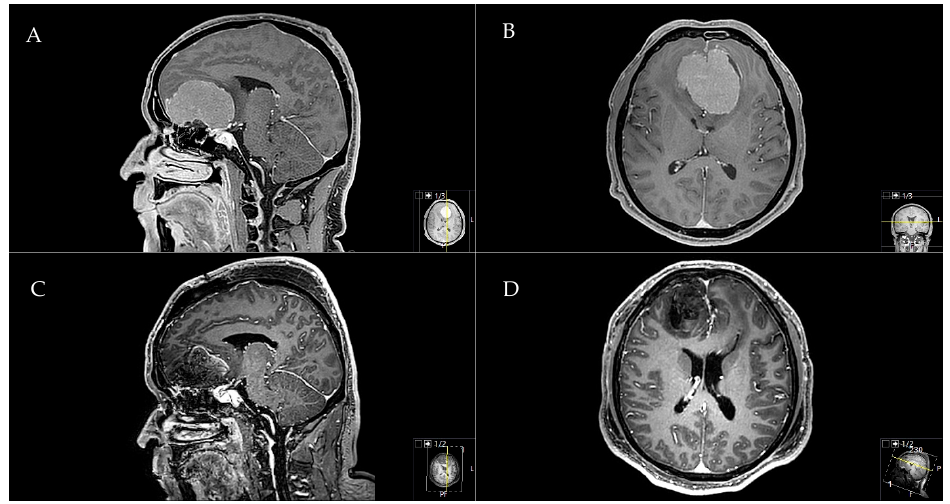
Figure 4. Exemplary case of a huge OGM.